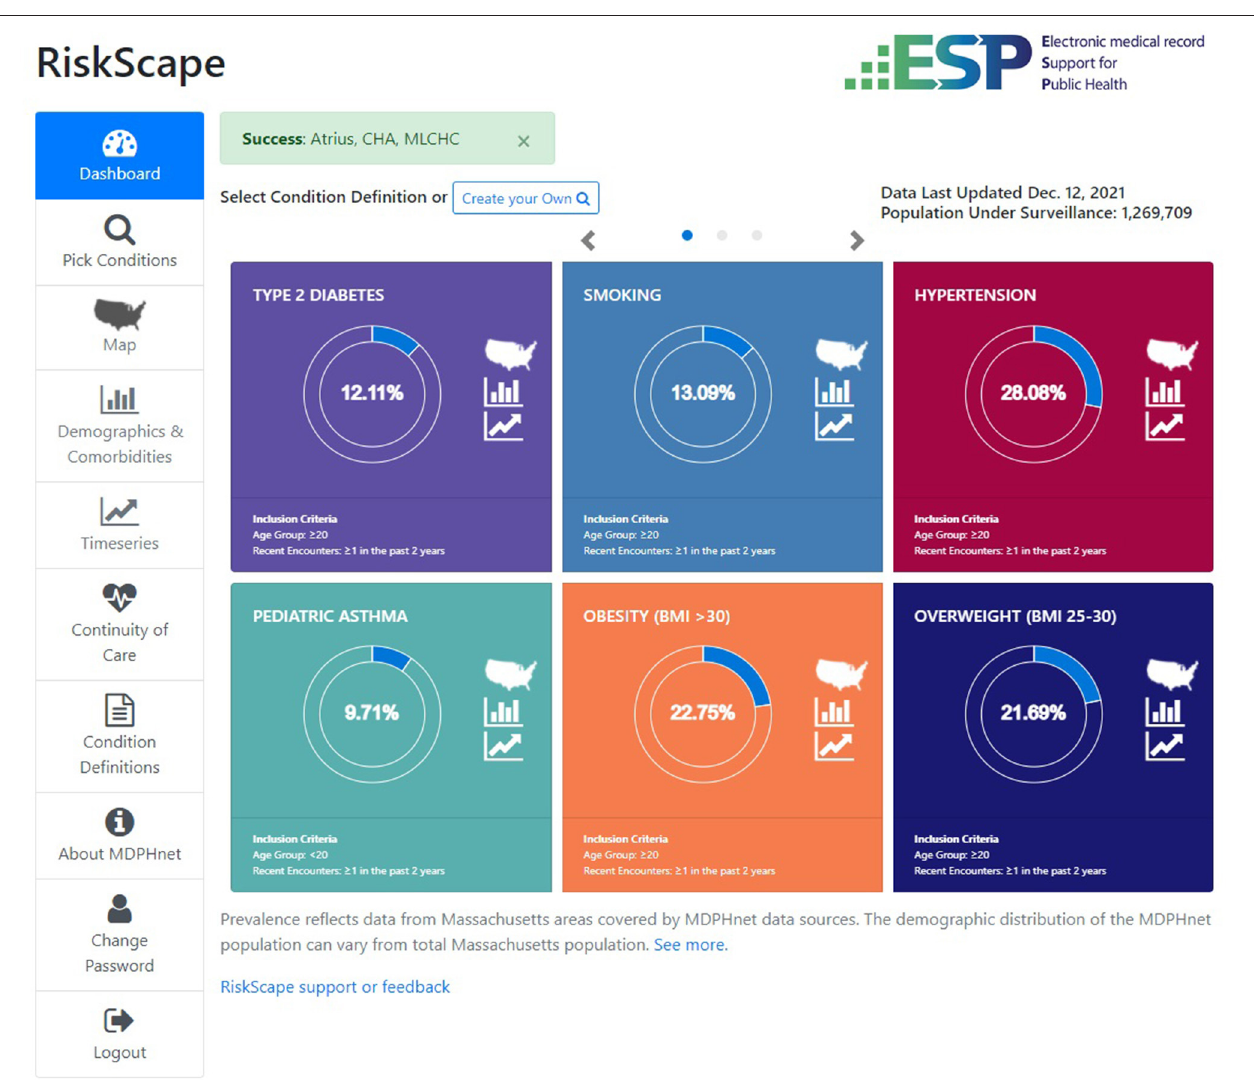
FIGURE 2 | RiskScape data visualisation platform